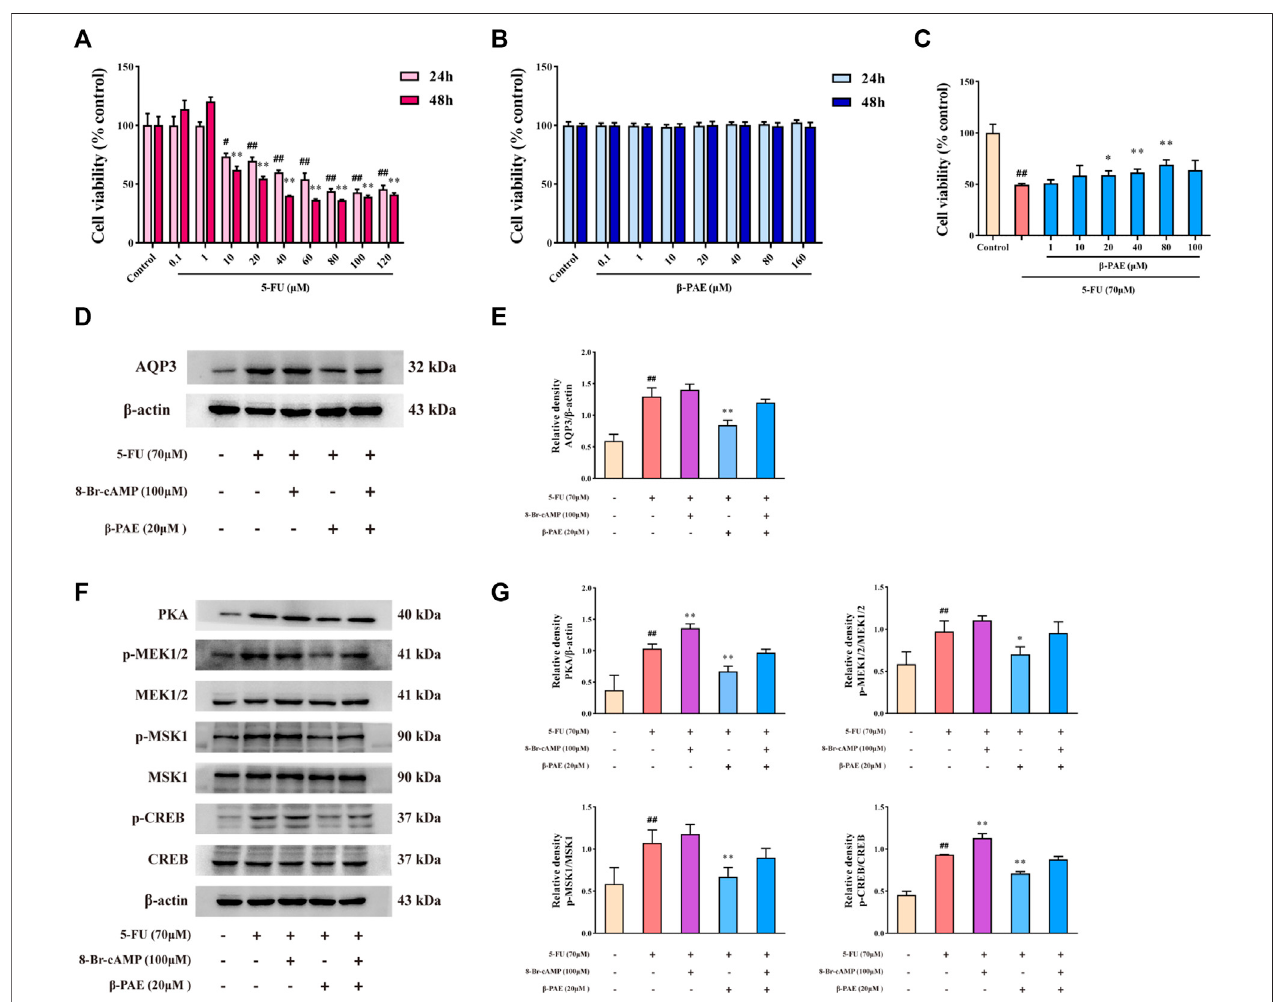
FIGURE2| Effectsof β -PAEonAQP3expressionandPKA/CREBsignalingpathwayinIEC-6cells.Cellviabilityfollowingtreatmentwithdifferentdosesof (A) 5-FU for24and48 hand (B) β -PAEfor24and48 h; (C) β -PAEenhanced5-FU-injuredcellviability; (D,E) AQP3expression; (F,G) PKA,p-MEK1/2,MEK1/2,p-MSK1,MSK1, p-CREB, and CREB expression. Data are shown as mean ± SD ( n (cid:2) 3). ## p < 0.01 versus control group; * p < 0.05, ** p < 0.01 versus 5-FU group.